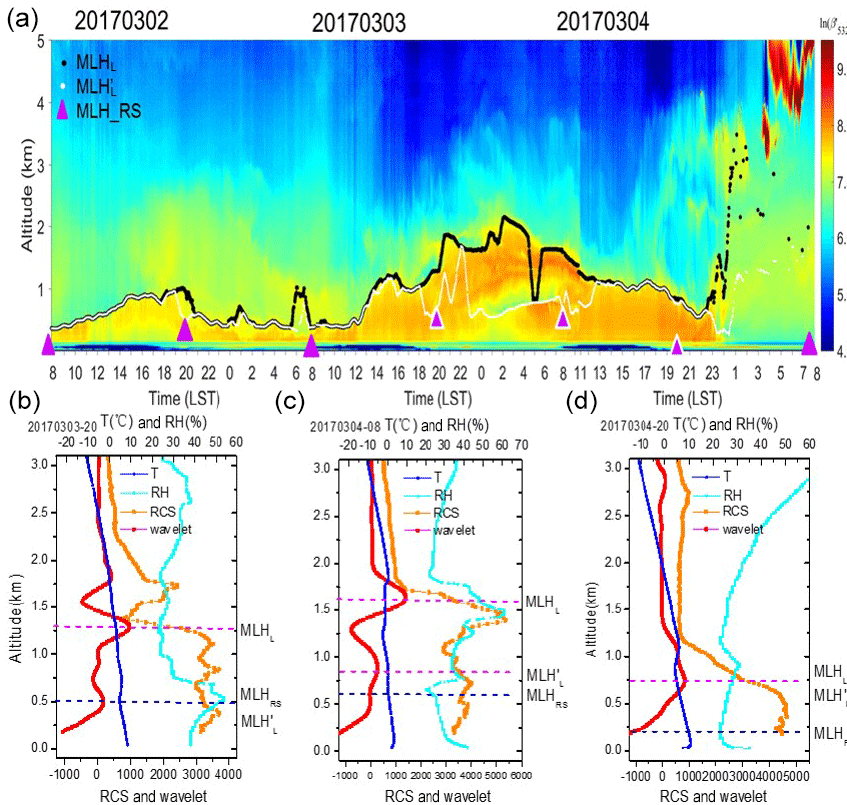
Figure 1. (a) Daily backscatter profiles from lidar for 2–4 March 2017. The lines connected by black dots in the figure represent the retrieved MLH L , while white dots line indicate the MLH (cid:48) , and the top of the purple triangle indicates the MLH RS identified from radiosonde. The L horizontal axis represents the local standard time (LST), and the vertical axis represents the height. The color bar denotes the logarithm of the (cid:48) )) . (b, c, d) The vertical profile of RCS (orange curve) from lidar and the wavelet coefficient attenuated backscattering coefficient (In( β 532 (red curve) of RCS, as well as the vertical profile of temperature ( T ) (blue curve) and relative humidity (RH) (cyan curve) for (b) 20:00 LST on 3 March 2017, (c) 08:00 LST on 4 March 2017 and (d) 20:00 LST on 4 March 2017, as indicated by the white-outlined triangle in panel (a)